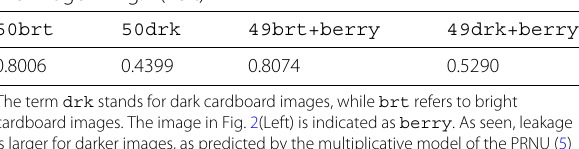
Table 2 Lower bound (6) for flat-field images with and without the image in Fig. 2(Left)